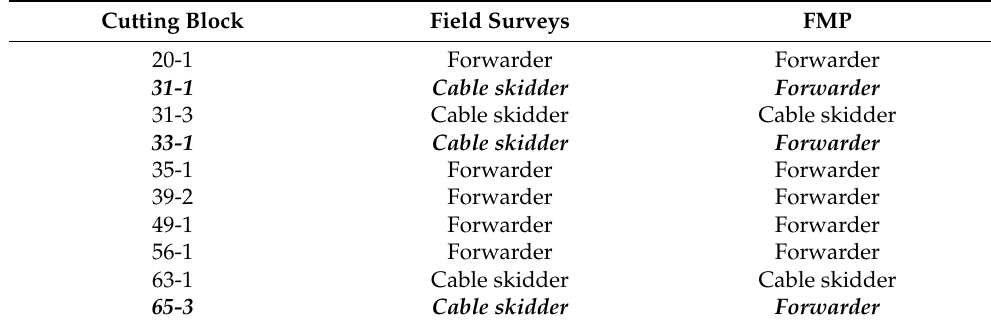
Table 4. Suggested extraction system for the investigated parcels with the output of the GIS-AHP procedure developed by the FMP data and field surveys carried out in the framework of this study. The italic bold indicates the cutting blocks with a different suggested extraction system between the two simulations. Cutting Block Field Surveys FMP 20-1 Forwarder